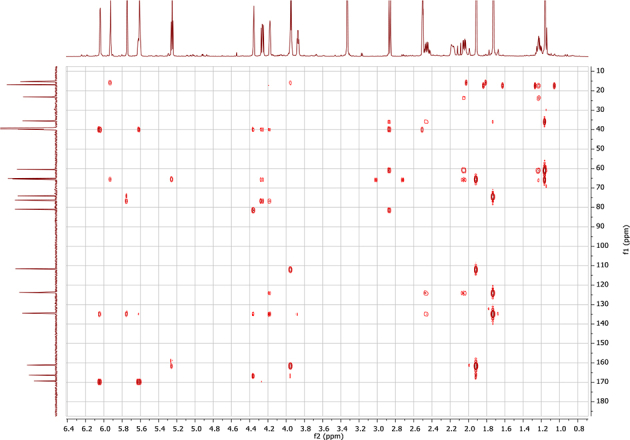
HMBC (DMSO-d6) spectrum of compound 5.